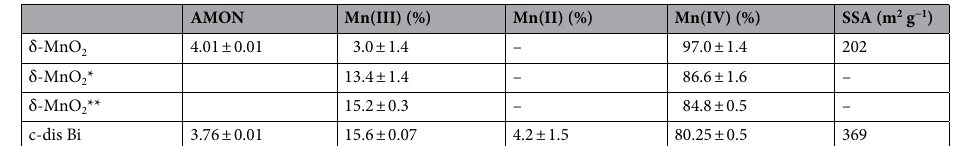
Table 1. Properties of synthetic Mn oxides used in this study. A 3-step titration was used to determine AMON values, while pyrophosphate extractions were used to quantify solid-phase Mn(III). The Mn(IV) and Mn(II) contents of c-disordered birnessite (c-dis Bi) were calculated from AMON and solid-phase Mn(III) content; for δ-MnO 2 , the Mn(II) content was below detection as the AMON is equal to 4.01. For δ-MnO 2 * and δ-MnO 2 **, the Mn(IV) content was calculated assuming no solid-phase Mn(II) as observed for δ-MnO 2 . Uncertainty in the calculated values was determined as the weighted sum of the variance, while the error for measured values is given as the standard deviation among